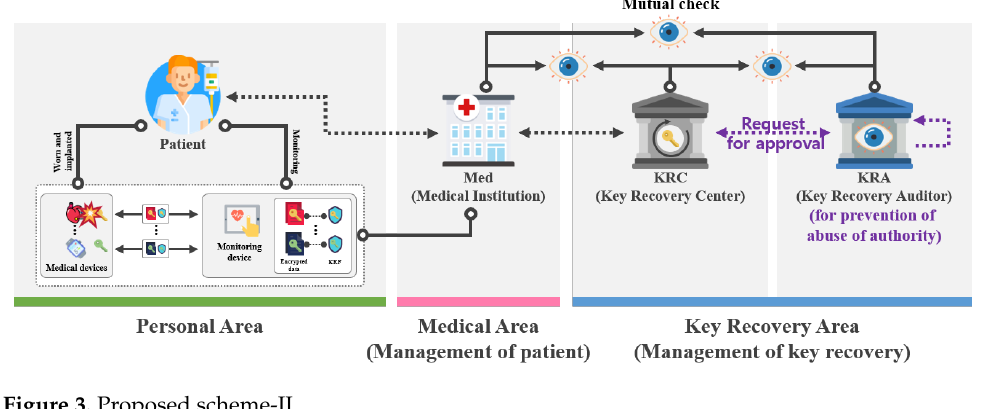
Figure 3. Proposed